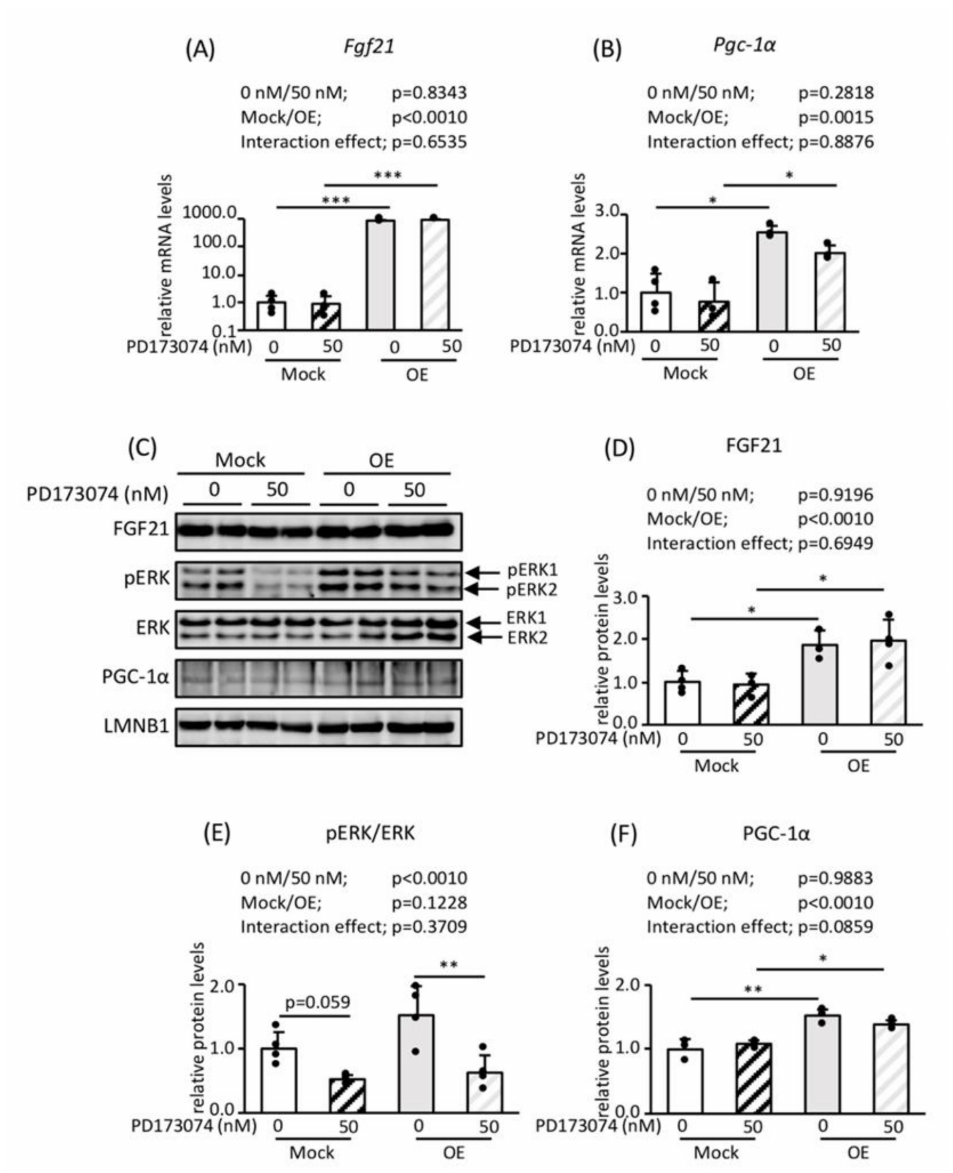
Figure 4. The e ff ects of FGF21 overexpression and the inhibition of FGFR on the expression of genes and proteins involved in FGF21 signaling and PGC-1 α in mature 3T3-L1 adipocytes. Control and FGF21 OE preadipocytes were di ff erentiated into mature adipocytes in four separate dishes for each phenotype, and they were treated with or without 50 nM PD173074, an FGFR inhibitor, for 24 h. ( A , B ) RNA was extracted and lysates were prepared from each dish. The mRNA expression levels of Fgf21 ( A ) and Pgc-1a ( B ) were determined using RT-PCR and normalized to Rps18 expression ( n = 4). ( C ) Representative immunoblot images showing the expression of proteins involved in FGF21 signaling and mitochondrial biogenesis. Quantitative analysis was performed using a chemiluminescence method. The protein expression of FGF21 ( D ) and PGC-1 α ( F ) is shown as the relative intensity of the indicated protein divided by that of LMNB1 as an internal control ( n = 4). Extracellular signal-regulated kinase (ERK) phosphorylation is expressed as the relative intensity of the phosphorylated form of ERK / total ERK ( n = 4) ( E ). Values are means ± SDs * p < 0.05, ** p < 0.01, *** p < 0.001 vs. controls administered the same